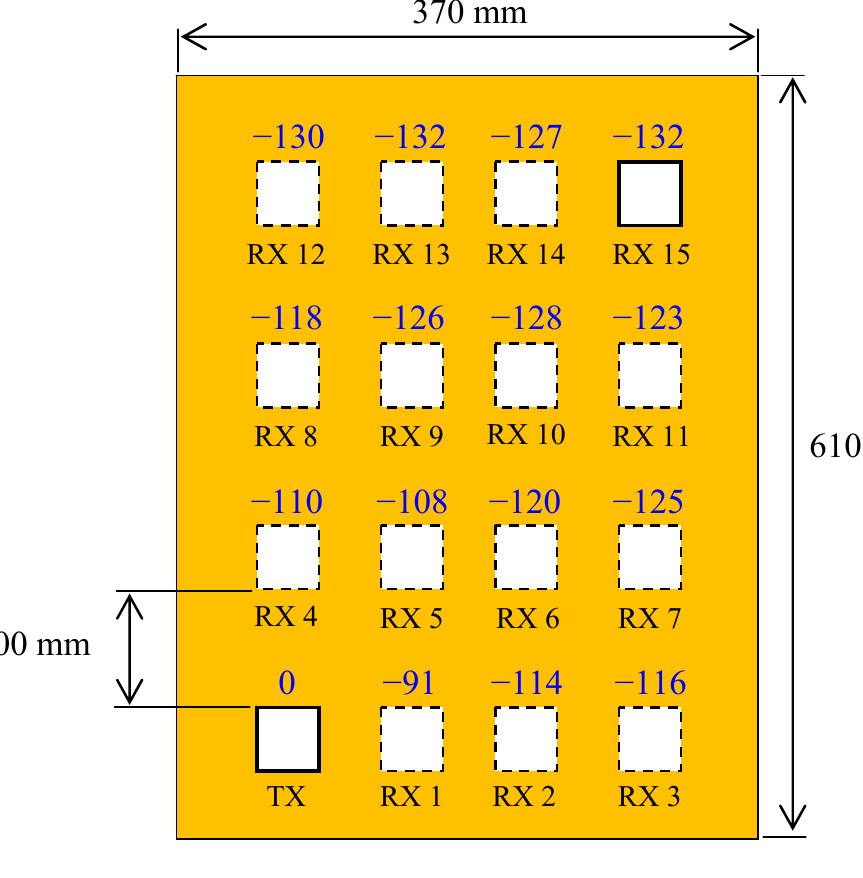
Figure 7. Received voltage on the chest phantom at 10 MHz [dB].